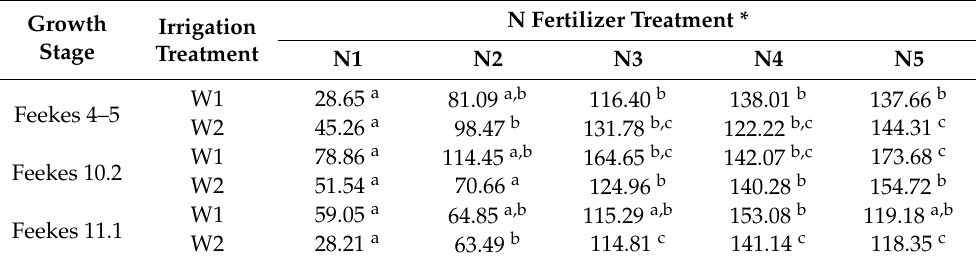
*: Numbers indicate the average LNC in the corresponding N and irrigation treatments. Within each row, the different letters indicate significant differences at the 0.05 level ( p < 0.05); W1: 80% field capacity; W2: 60%